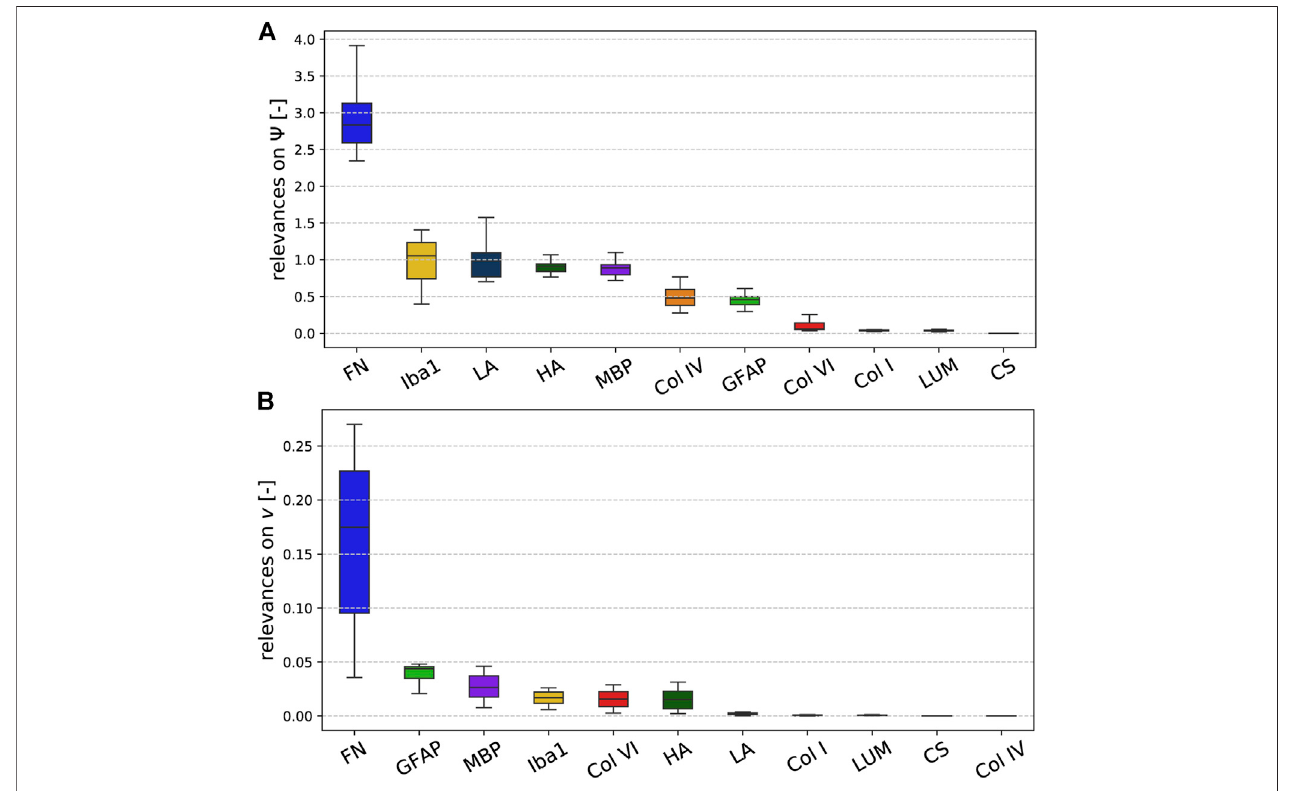
FIGURE8| RelevanceoftheELISAvaluesforthe (A) quasi-elasticstressresponseonveryshorttimescales(governedby Ψ )and (B) viscoelasticeffects(governed by the Prony series parameters collected in the set v ).